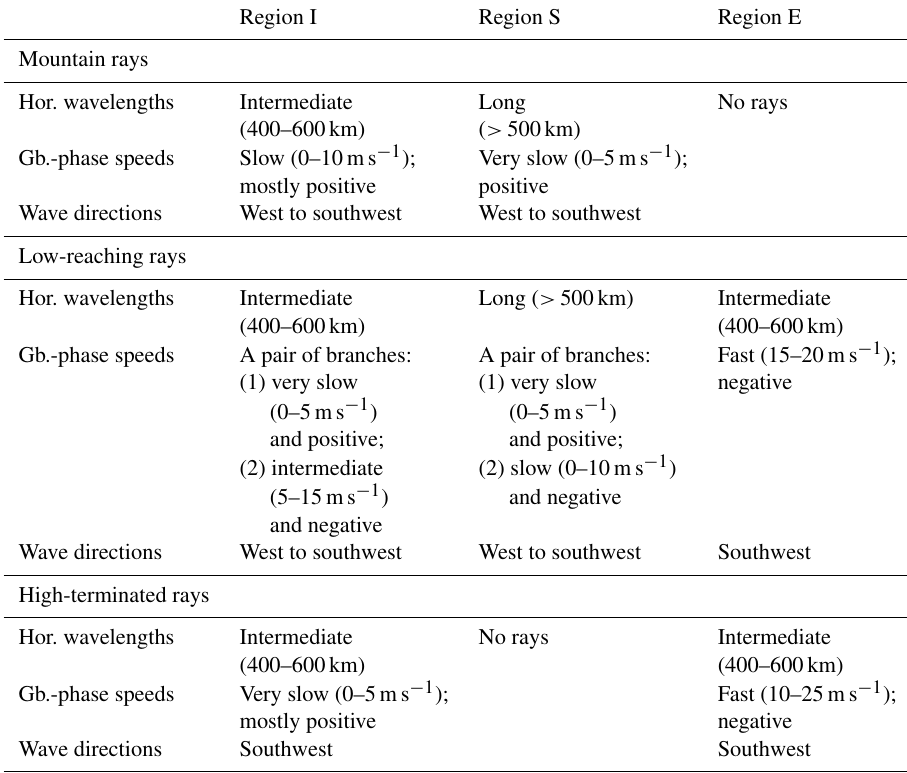
Table 1. Characterisation of waves in temperature amplitude maximum regions I, S, and E with respect to their ray category of mountain, low-reaching, and high-terminated rays. Note: Hor. – horizontal; Gb. – ground